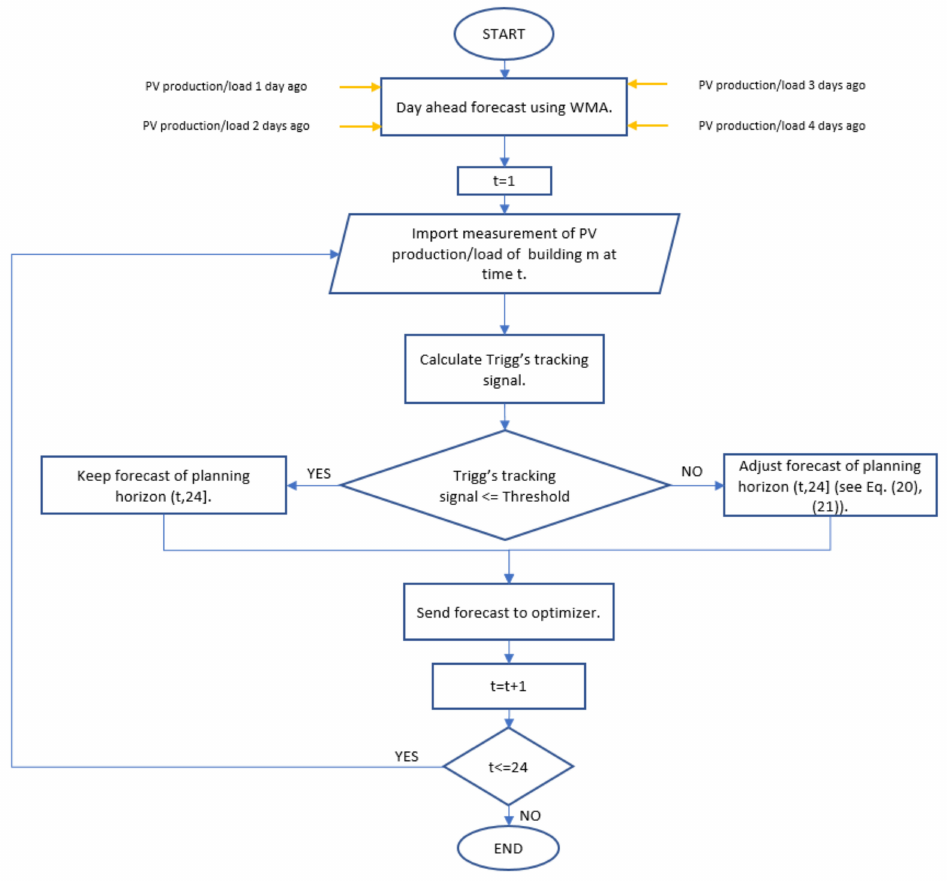
Figure 3. Flowchart of forecasting